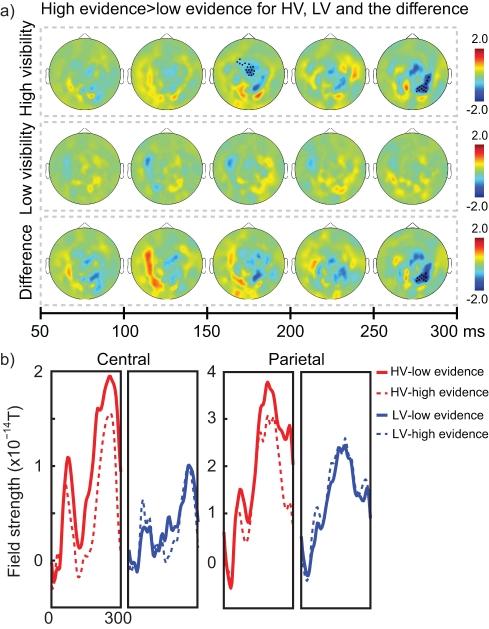
Neural markers of accumulated evidence.(A) Topographical representation of larger activity for arrows when the amount of previously accumulated evidence was low (low evidence), compared to when the amount of previously accumulated evidence was high (high evidence). Other conventions as in Figure 2. (B) Time course of central and parietal clusters. Central activity is plotted for the cluster that showed significantly reduced activity when accumulated evidence is high for HV arrows in the 150–200 ms interval. Parietal activity is plotted for the cluster that showed significantly stronger effects of accumulated evidence for HV than LV arrows in the 250–300 ms interval.